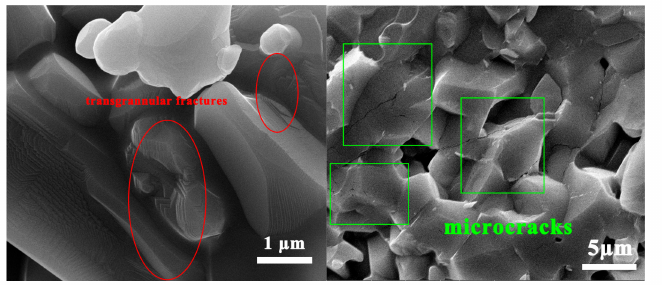
Figure 10. Micrographs of Fracture Toughness Enhancement Mechanism Analysis. ( a ) transgranular fracture. ( b ) microcrack